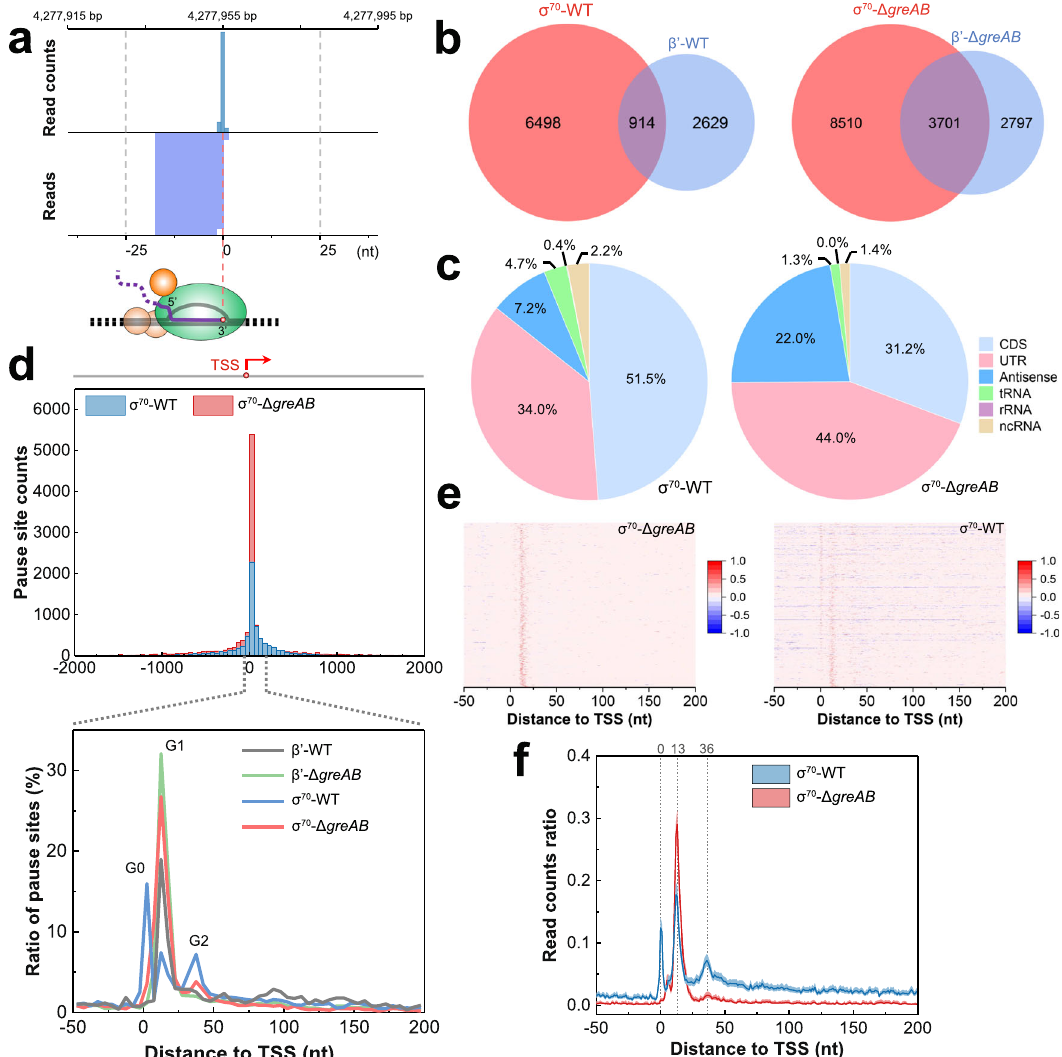
Fig. 2 Classi fi cation of σ 70 -dependent transcription pauses. a Example of σ 70 -dependent pause upstream of the yjcE coding sequence (CDS) identi fi ed by RNET-seq in the σ 70 - Δ greAB strain. The genomic coordinates for 3 ’ ends of all uniquely mapped RNA reads (bottom lane) were determined and the read count for each 3 ′ end position was calculated and plotted (top lane). The genomic positions where 3 ’ end/3 ’ end median (51-bp window) read counts ratio (pause score) was ≥ 20 and read counts/10 6 reads was ≥ 10 satis fi ed our stringent de fi nition for a pause site. b Venn diagrams show the total and shared numbers of pauses identi fi ed in σ 70 -WT ( n = 7412), β ’ -WT ( n = 3543), σ 70 - Δ greAB ( n = 12211) and β ’ - Δ greAB ( n = 6498) strains. c Distribution of σ 70 - dependent pauses among CDS, UTR, Antisense, tRNA, rRNA and ncRNA regions in σ 70 -WT and σ 70 - Δ greAB strains. The “ Antisense ” pauses included those in CDS, tRNA, rRNA and ncRNA genes. d Distribution of pause sites in promoter-proximal regions. The TSS coordinates identi fi ed by dRNA-seq 64 were used to plot pause counts against the pause distance from the nearest TSS on the same DNA strand. The zero and positive coordinates correspond to the pauses overlapping the TSS or located downstream of the TSS, respectively. The upper panel shows the counts of pauses in 50-nt bins within − 2000/ + 2000-bp window centered at the TSS. The bottom panel shows the ratio obtained by dividing the count of pause sites in a 5-bp sliding window to the total count of pause sites in the − 50/ + 200-bp register surrounding the TSS. Heatmap ( e ) and mean ( f ) of the read counts for σ 70 - Δ greAB G1 pause sites ( n = 3099) in σ 70 - Δ greAB (left) and σ 70 -WT (right) strains. The pause sites were ranked based on the pause score (described in a ). The counts of reads aligned to the sense and antisense strands in each coordinate were normalized to 0 to 1 and 0 to − 1 by dividing the maximum read count in each − 50/ + 200-bp region. The regions with multiple pause sites were counted only once ( e ). The dashed line and number on the top indicate the distance of the peak from the TSS. The line and the shadowed region represent the mean and 95% con fi dence interval for the read counts ratio ( f